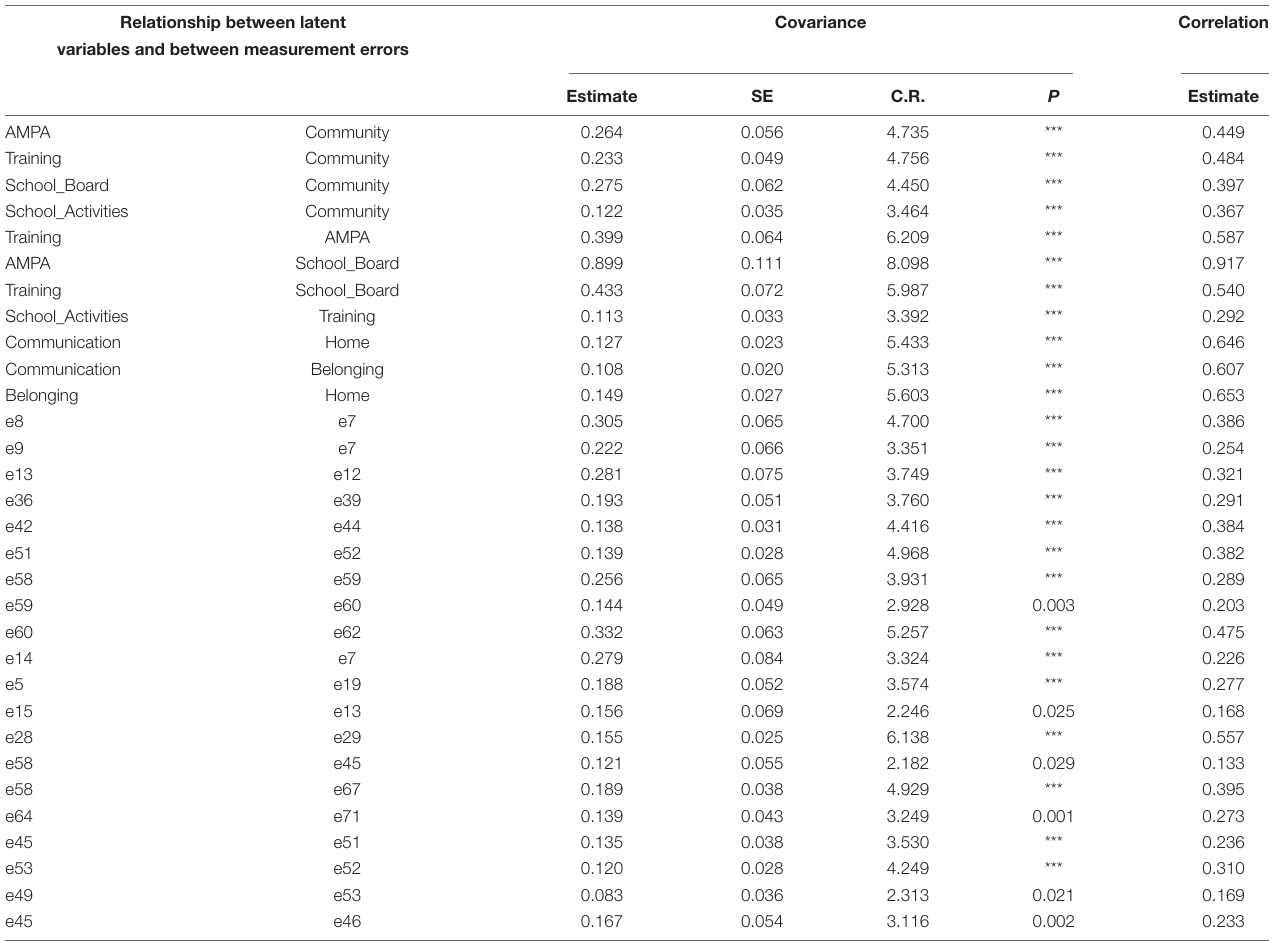
TABLE 5 | Covariance and correlation between latent and observable variables. Relationship between latent Covariance Correlation variables and between measurement errors Estimate SE C.R. Estimate